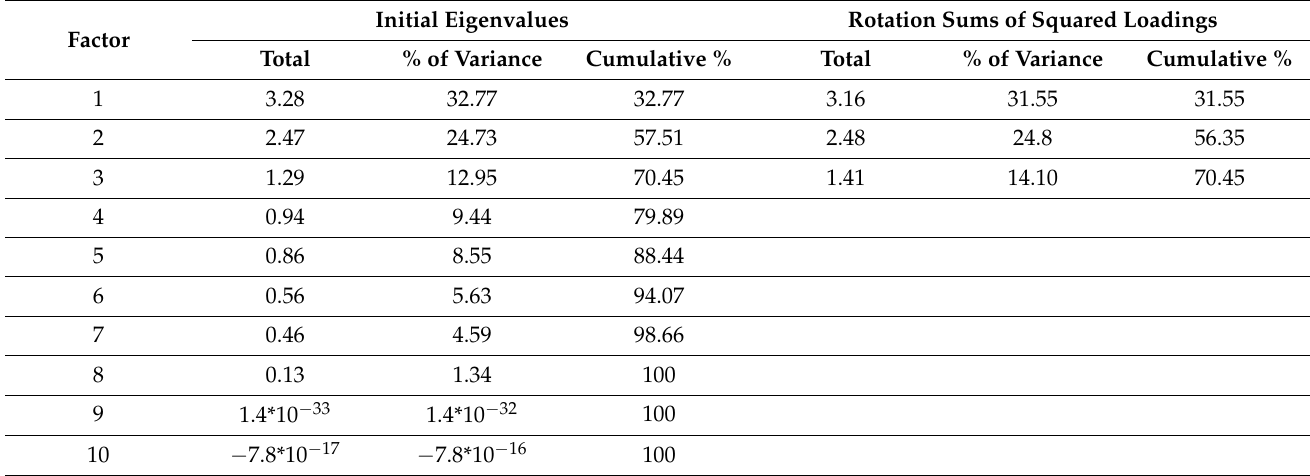
Table 4. The total variance explained with Eigen values for the